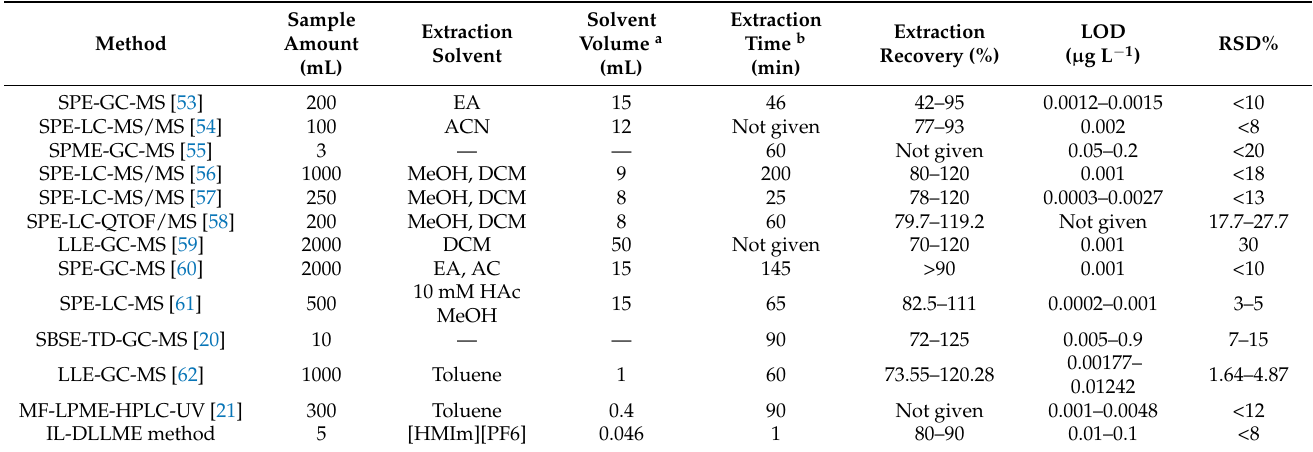
Table 2. Comparison of the IL-DLLME method with other procedures for the determination of antifouling biocides in water samples.